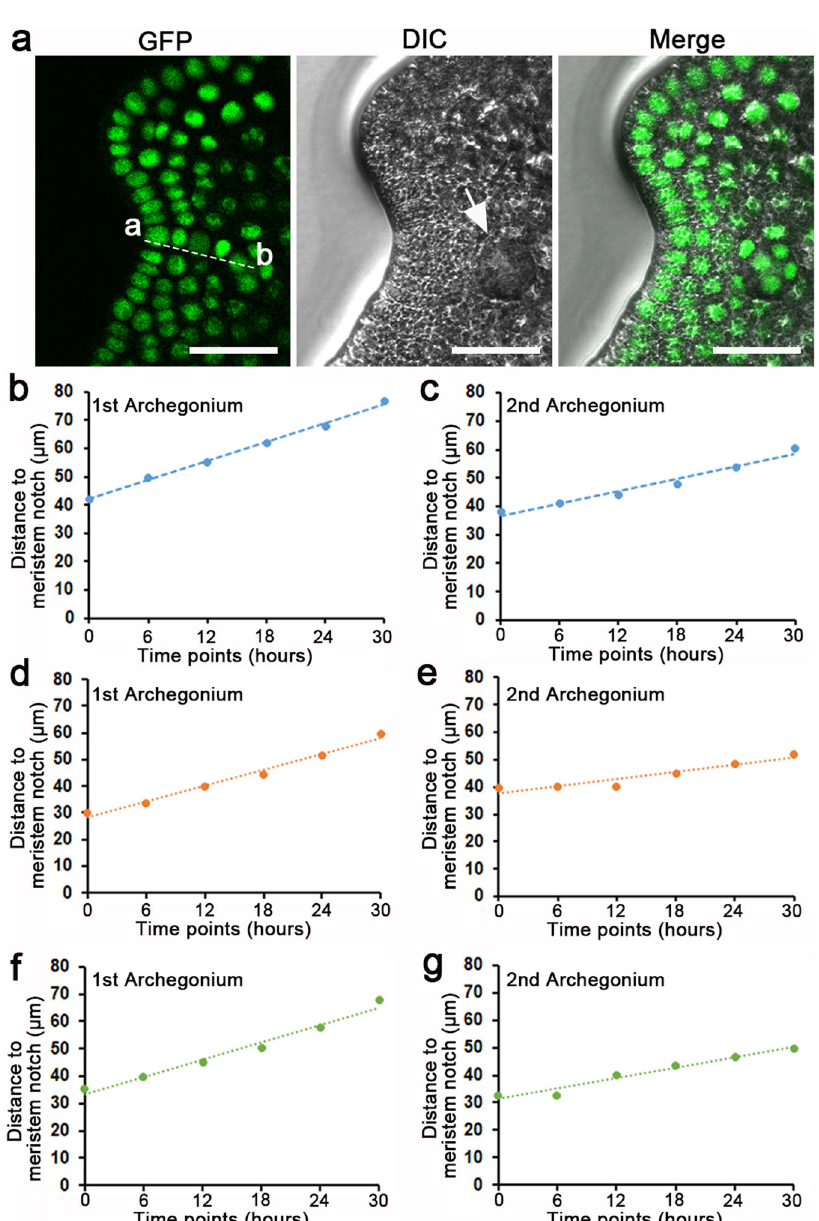
Fig. 7 The dynamic distance between archegonia and the meristem notch during gametophyte development. a The calculation of distance between a meristem notch (or the location where the meristem notch will be formed) (point a) and the center of an archegonium (point b) in one representative image. The image in ( a ) is the part of one optical section of the sample shown in Fig. 2m. Scale bar: 50 μ m. b – g Dynamic distances between archegonia and meristem notches. Y axis: Distance between a meristem notch and an archegonium. X axis: six consecutive time points starting from initiation (shown as 0 h in the graphs) of the archegonium. The distance in b and c was calculated based on the confocal images of the gametophyte shown in Fig. 2, and the fi rst and second archegonia started to initiate at 54 h and 84 h, respectively. The distance in d and e was calculated based on the confocal images of the gametophyte shown in Supplementary Fig. 4, and the fi rst and second archegonia started to initiate at 54 h and 90 h, respectively. The distance in f and g was calculated based on the confocal images of the gametophyte shown in Supplementary Fig. 5, and the fi rst and second archegonia started to initiate at 60 h and 84 h, respectively. The source data for ( b – g ) are included in Supplementary Data